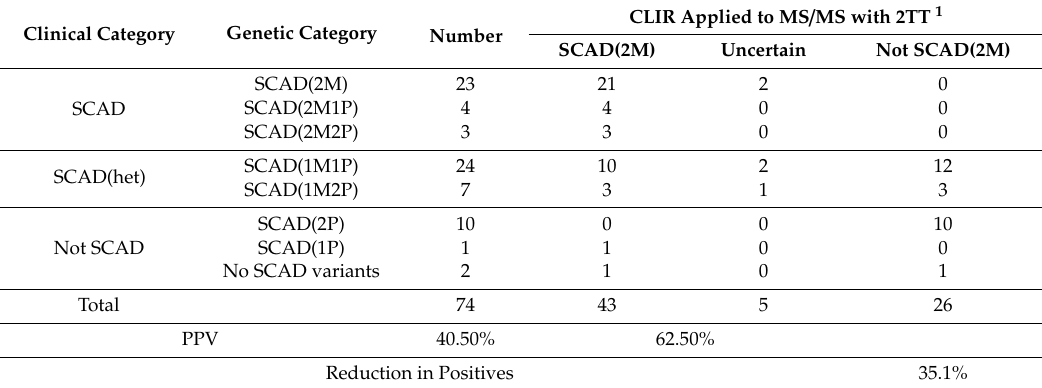
Table 3. Results of second-tier testing with CLIR results before tuning based on genotype. Clinical